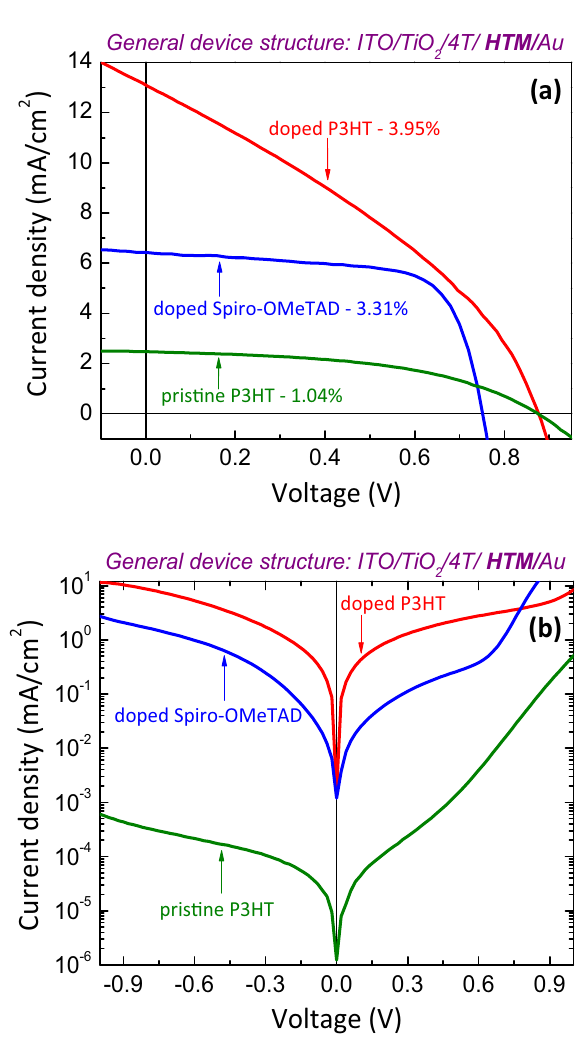
Figure 3. ( a ) J–V characteristics of ITO/TiO 2 /4T/HTM/Au solar cells under simulated irradiation of 100 mW/ cm 2 (1 sun) with Air Mass 1.5 filter and ( b ) semi-log J–V plot of the solar cells in dark. Here, the 4T dye is used as an interface modifier and HTMs are pristine P3HT, doped P3HT and doped